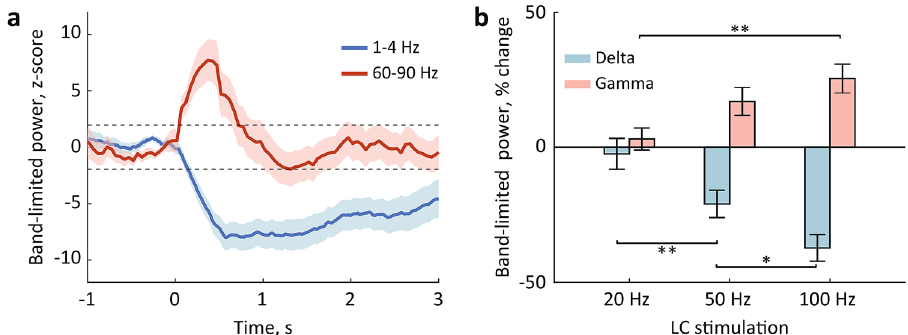
Figure 3. The EEG modulation by LC stimulation. ( a ) The EEG delta (1–4 Hz) and gamma (60–90 Hz) power around LC stimulation. Averages over 14 sessions (n = 7 rats) are plotted for LC stimulation at 100 Hz; shadows show s.e.m. ( b ) The delta and gamma power change produced by LC stimulation. *p < 0.05, **p < 0.01 (post hoc comparisons, Bonferroni